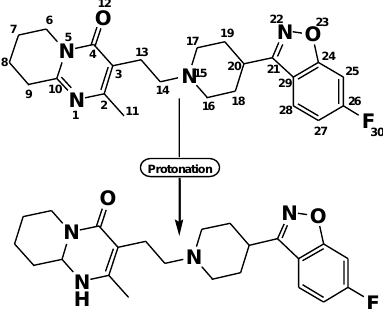
Figure 1. Proton transfer of risperidone drug.